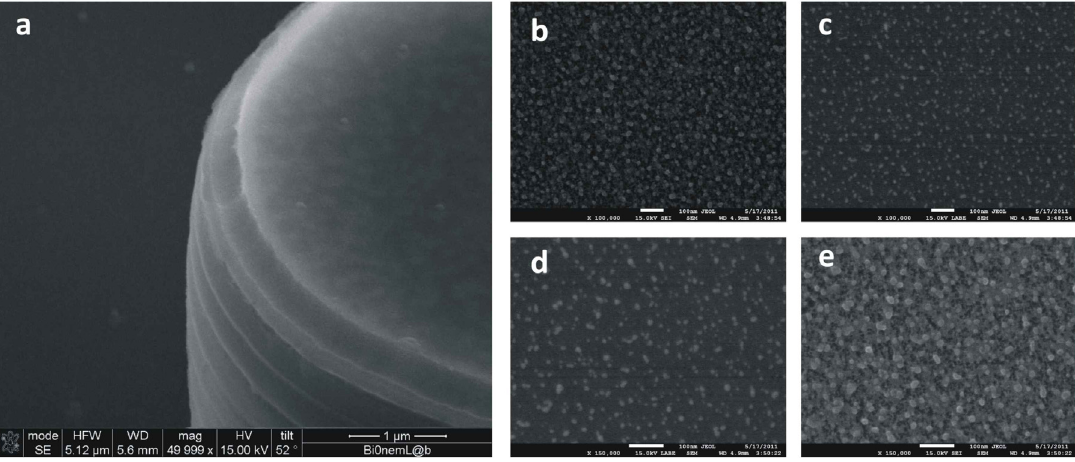
Figure 4. Micro-textures of nanoporous silicon pillars where electroless silver nanoparticles are infiltrated into the pores. In ( a ), at a smaller scale, you may observe the micro-pillar covered with the nano-porous silicon film. In ( b – e) , at larger scale, you can notice the morphology of the nano-porous matrix and of the silver nano-particles infiltrated into the